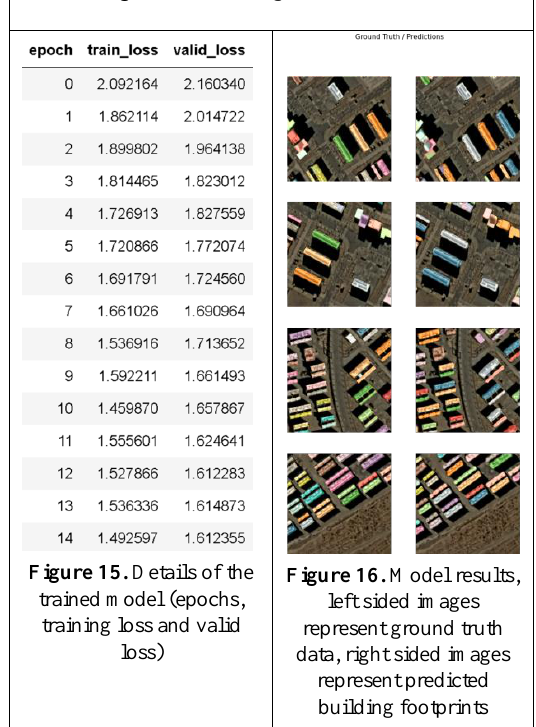
Figure 15. Details of the Figure 16. Model results, trained model (epochs, left sided images training loss and valid represent ground truth loss) data, right sided images represent predicted building